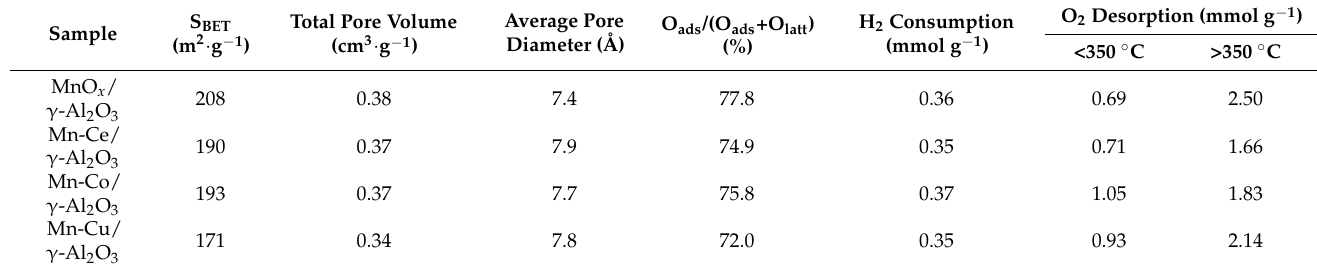
Table 1. Physicochemical properties of the Mn-X/ γ -Al 2 O 3 catalysts.